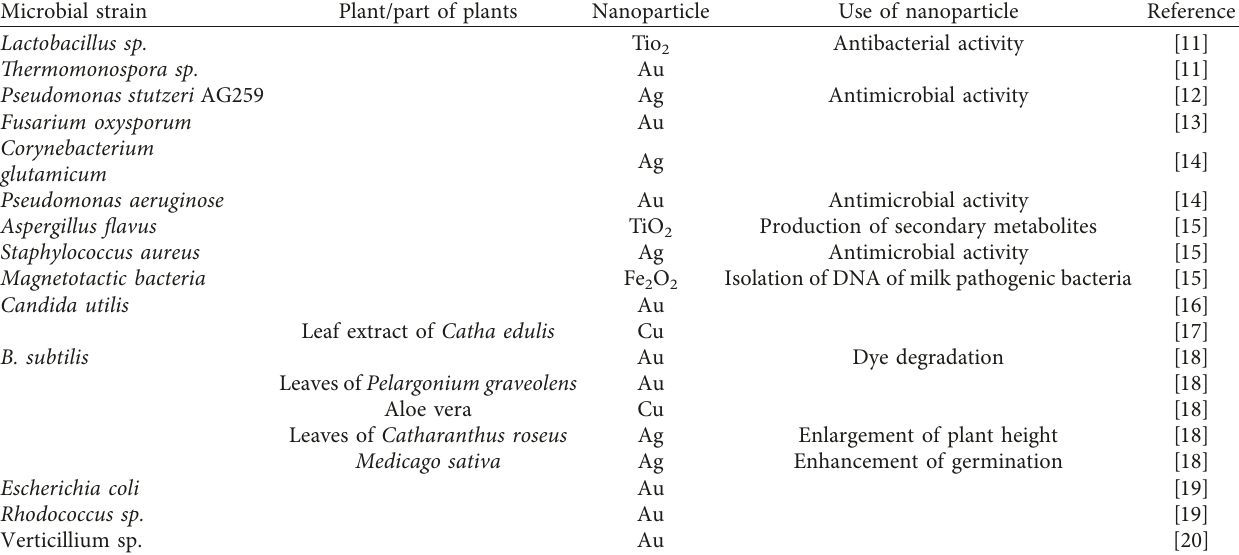
Table 1: Some of the nanoparticles synthesized by microorganisms/plants and their possible role in the agri-food system. Microbial